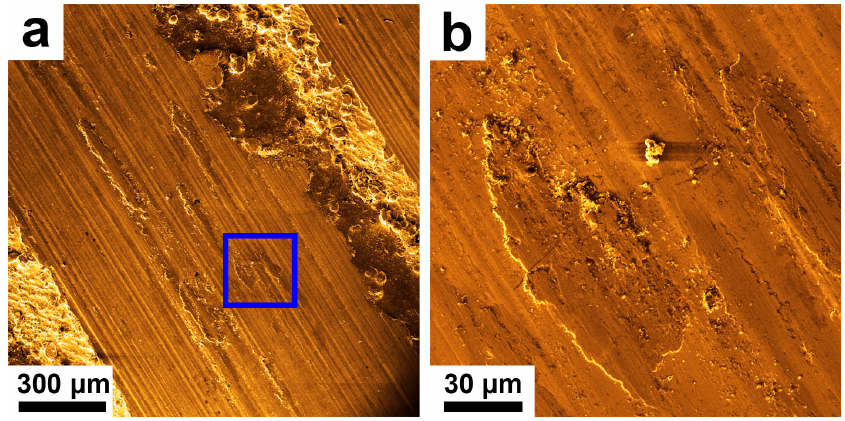
Figure 9. The SEM images of the wear scar of Fe–Si–Al coating specimen 4. ( a ) the wear scar of coating specimen 4; ( b ) the enlarged SEM image of ( a ).